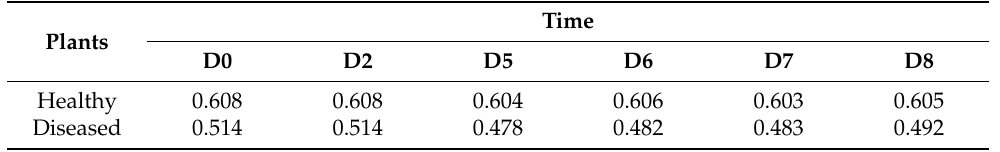
Table 6. Second-order fractional moment of PZ distribution of the ratio for the healthy and diseased leaves of the bacteria data set. D0, ..., and D8 are the six days of the acquisition of chlorophyll fluorescence